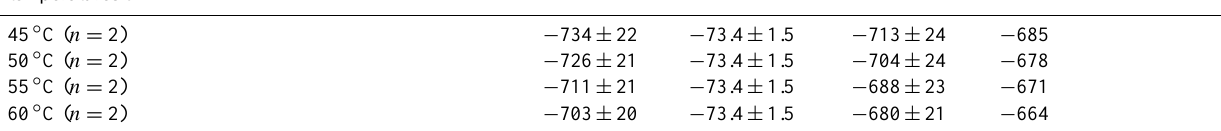
Table 2. Isotopic source signature of produced H 2 ( δD H fractionation constant ε between H 2 and H 2 O, ε H ε from Bottinga (1969) are interpolated to the actual temperature. All values are in ‰. Sample origin δD H